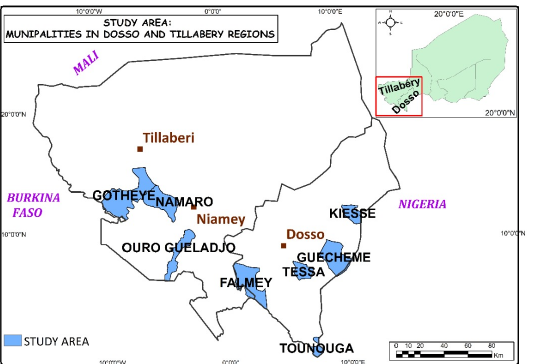
Figure 1. Study areas in Southwestern Niger (Tounouga, Namaro, Ouro-Ghéladjo, Kiéché, Gothèye, Guéchémé, Tessa, and